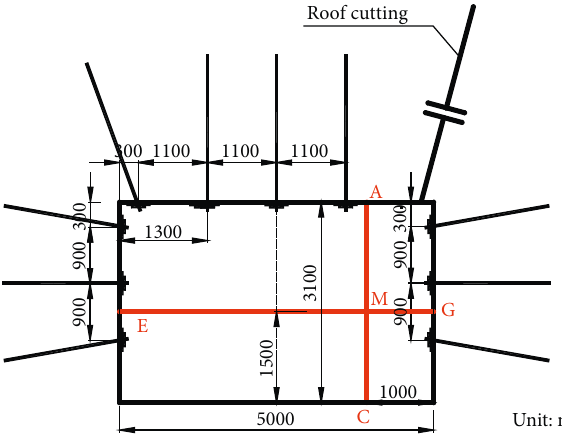
Figure 17: Deformation monitoring scheme of retained entry.